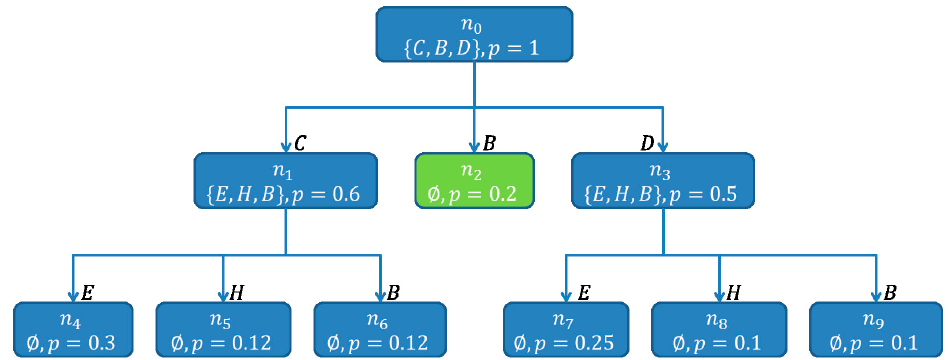
Figure 15. The SHSDAG after the expansion of n 1 and n 3 . The nodes n 1 and n 3 are both labeled with CS E = { EHB } . The new child nodes n 4 , n 5 , n 6 of n 1 and the new child nodes n 7 , n 8 , n 9 of n 3 have been created. The node n 2 was labeled as end _ of _ path and is a hitting set (therefore depicted in green). Figure 16 shows the SHSDAG after this step.